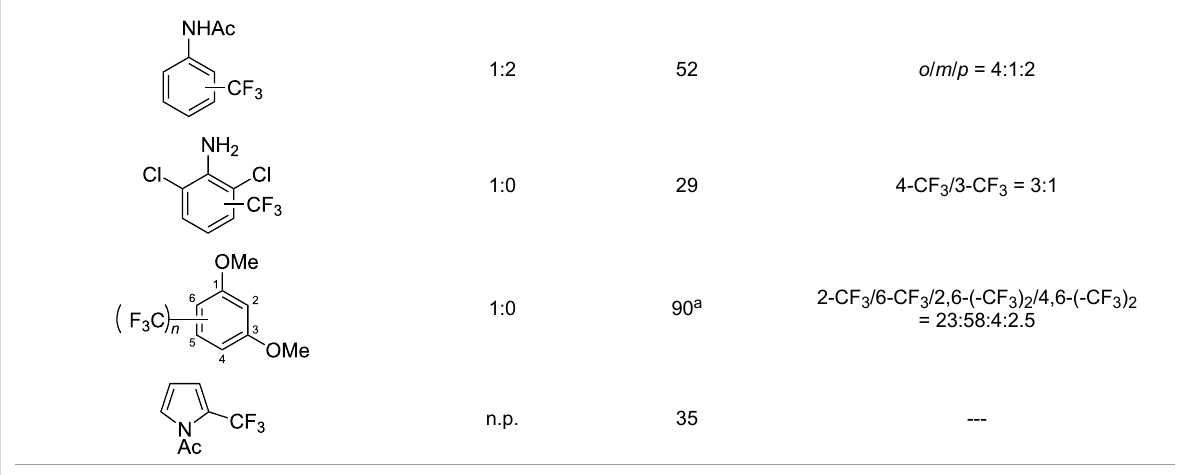
Table 19: Cu-catalyzed trifluoromethylation with Langlois’s sodium trifluoromethanesulfinate as CF 3 radical source [88]. (continued)